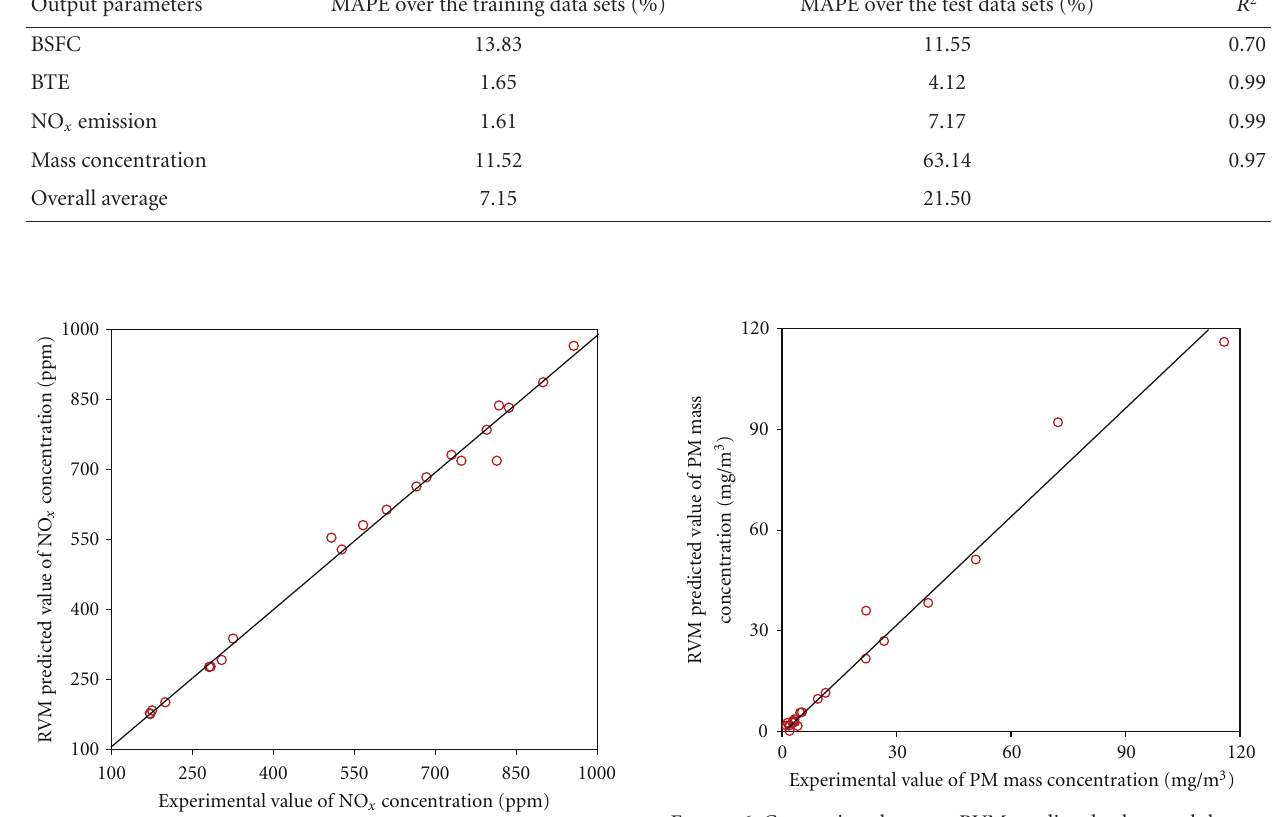
Figure 5: Comparison between RVM predicted values and the cor- responding actual values for NO x concentration.